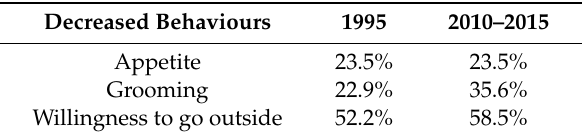
Table 2. Decreased behavioural changes 1 . Percentages from both surveys where behavioural changes were reported to be decreased by the owners of the elderly